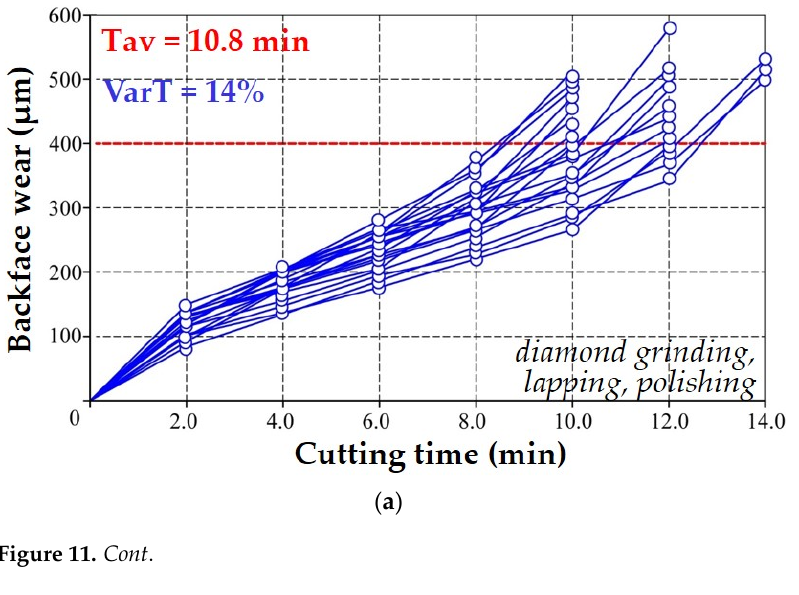
Figure 10. Group of “wear–cutting time” curves of cutting faces of ceramic inserts made of Al 2 O 3 +TiC after diamond grinding when milling hardened steel 100CrMn6 (V = 380 m/min, S = 0.15 mm/tooth, t = 1 mm) uncoated ( a ) and coated with (TiZr)N ( b ).